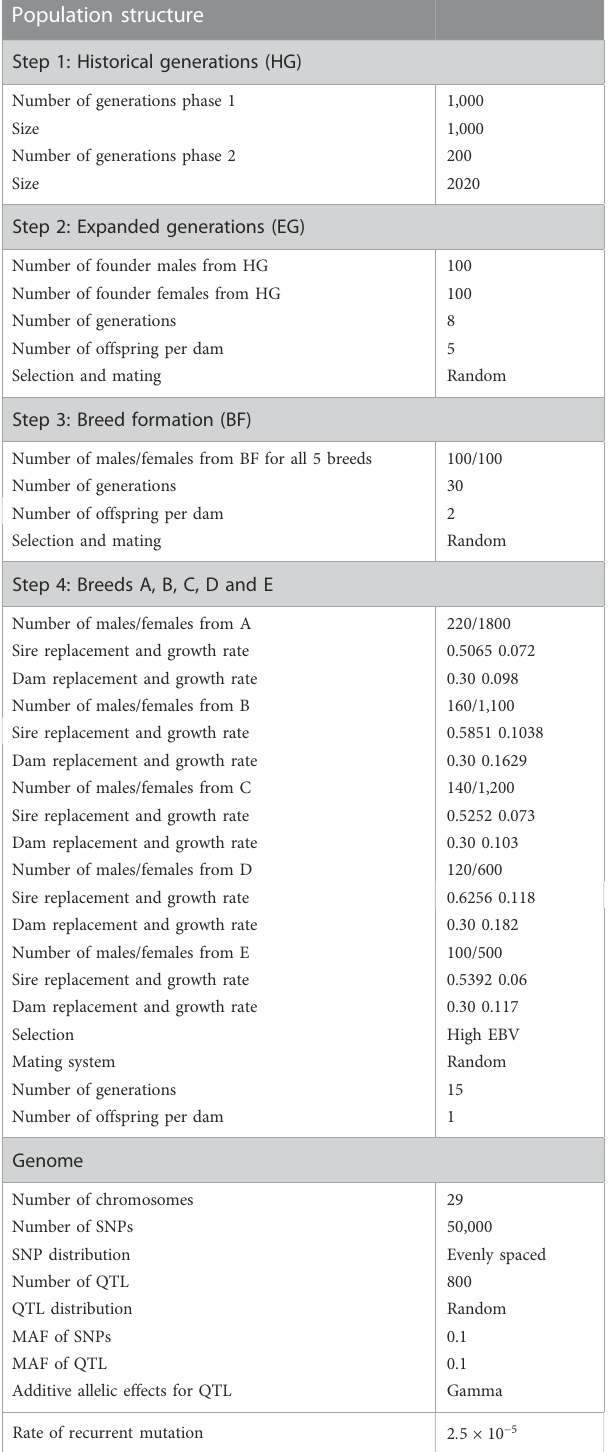
TABLE 1 Parameters of the simulation